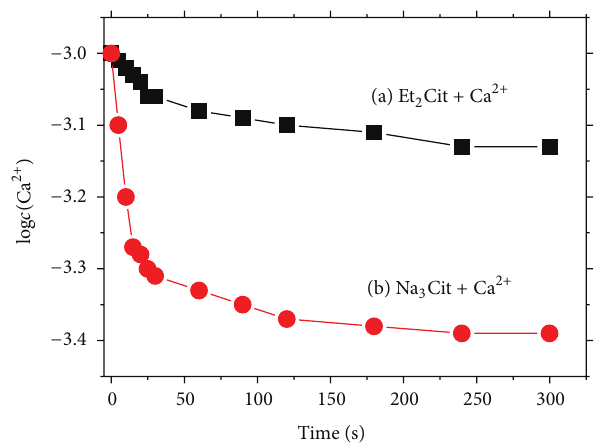
Figure 1: Changes in Ca 2+ concentration with reaction time in different systems: (a) Et 2 Cit-Ca 2+ system and (b) Na 3 Cit-Ca 2+